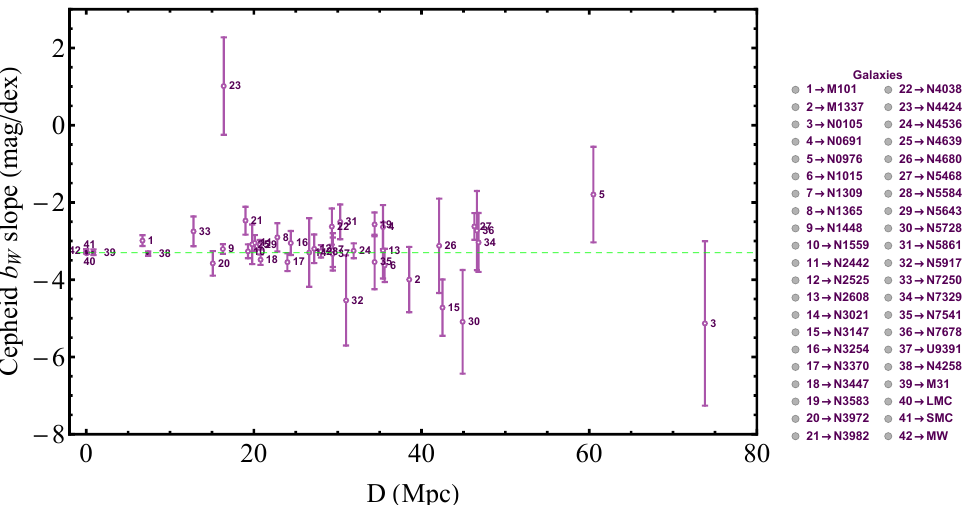
Figure 1. Independently fitted slopes b W , i of the Cepheid P-L relations. Here, we ignored non- diagonal terms of the covariance as was done in R21 in the corresponding Figure 10. There is a consistent trend of most non-anchor hosts having a best-fit absolute slope | b W | that is smaller than corresponding best fit b W of the anchor hosts (above the dotted line). The dotted line corresponds to + ∆ b = − 0.286 − 0.013 = − 0.299 in the context of the baseline SH0ES the best-fit value of b W = b 0 W W analysis as shown in Table